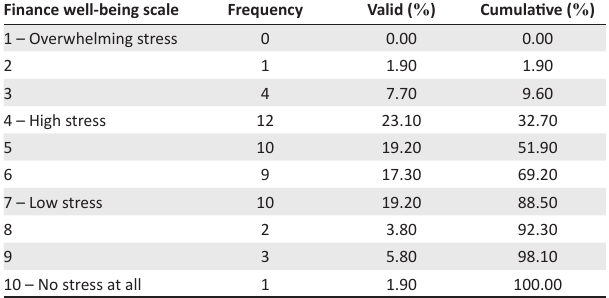
TABLE 1: What do you feel is the level of your financial stress today? Finance well-being scale